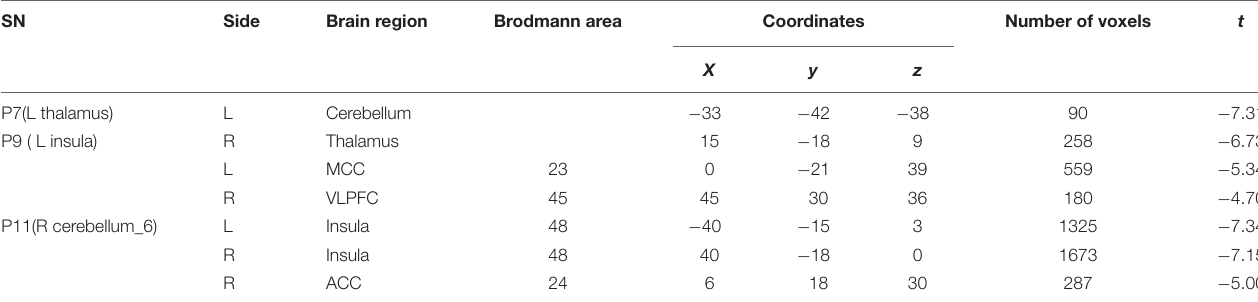
TABLE 2 | Brain regions demonstrating group differences of the iFC between SN subregions and whole brain voxels in patients with OCD.